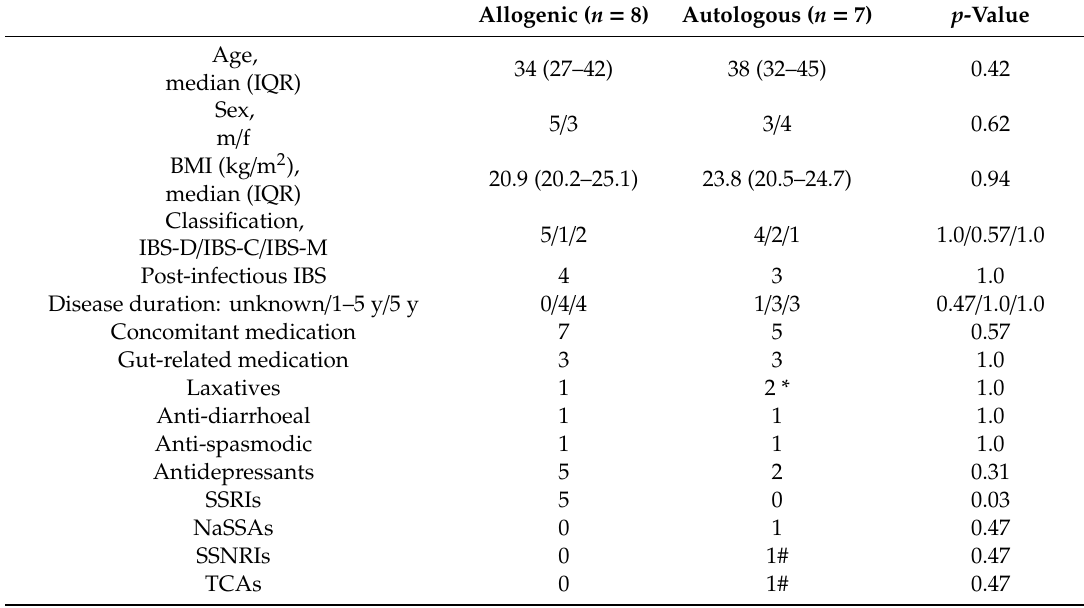
Table 1. Baseline characteristics of irritable bowel syndrome (IBS) patients included in this